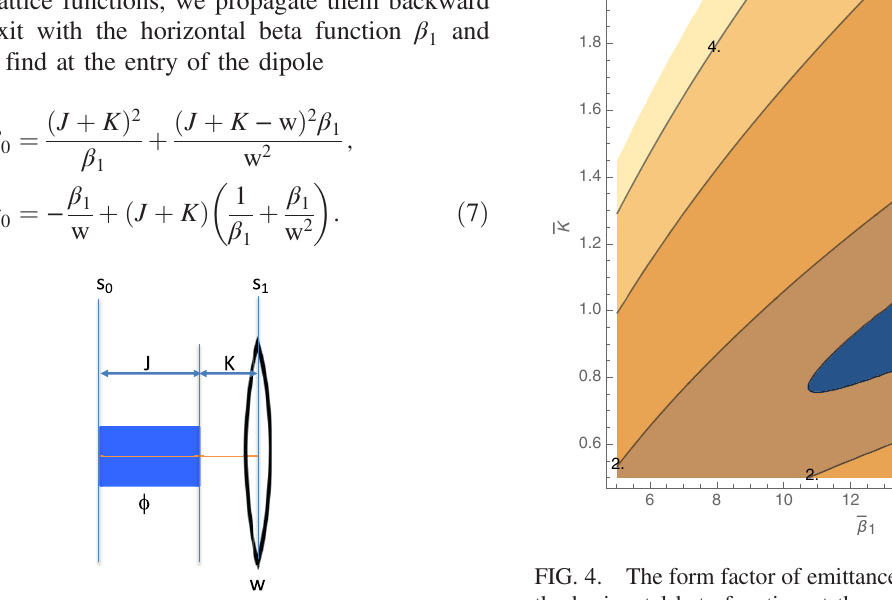
FIG. 3. Half of the dispersive region in the DBA cell.